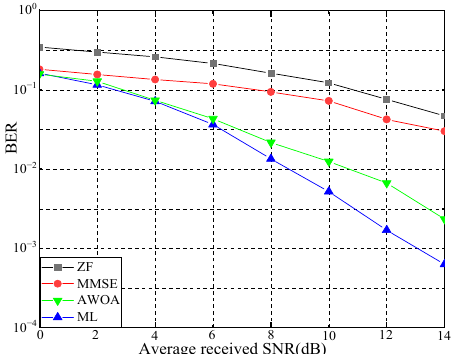
Figure 8. BER in 4*4 MI-MIMO.